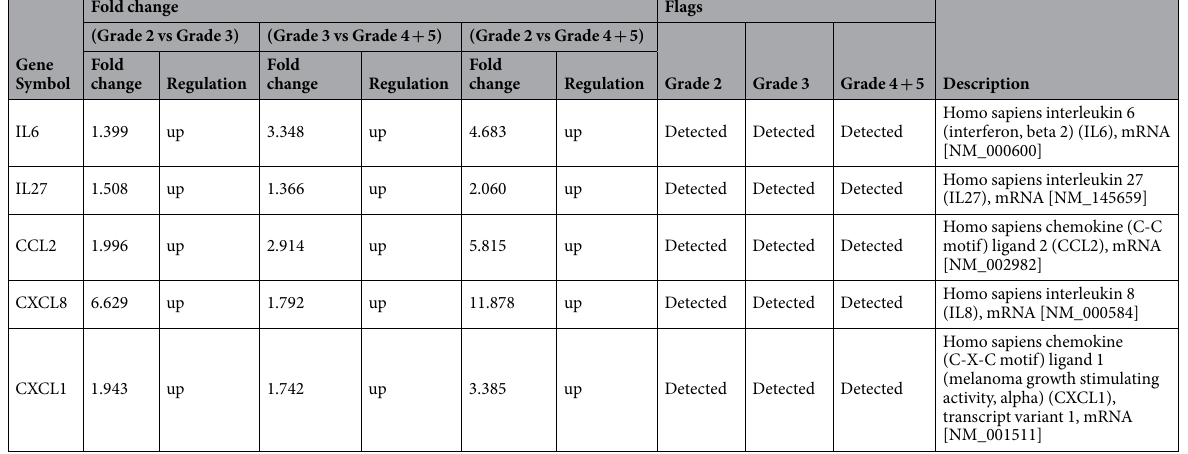
Table 4. The microarray data of CXCL1, IL-6, CXCL8, IL-27, CCL2 and CXCL8 in the different grades of NP